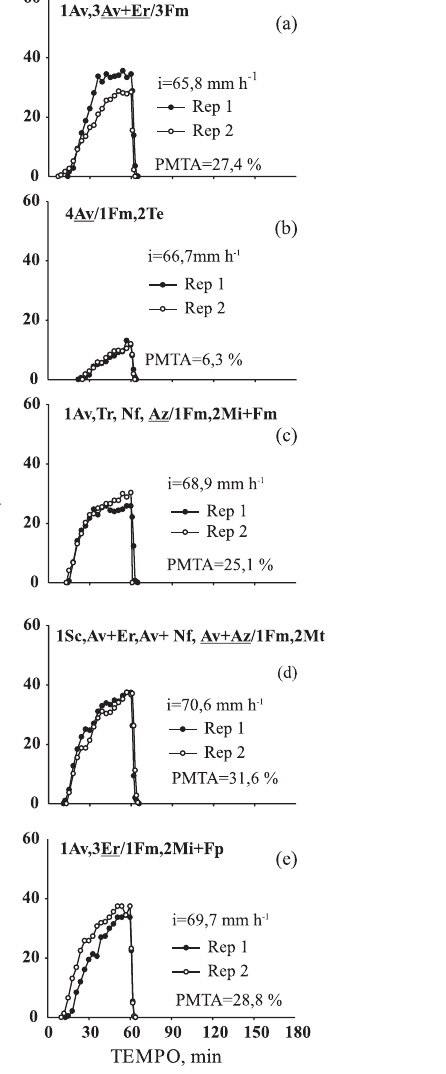
Figura 2. Taxas instantâneas de descarga da enxurrada (TDE) no terceiro (T3: solo não imobilizado, raízes mortas, crosta recente, 18 % coberto - figuras (a) a (e), à esquerda) e no quarto (T4: solo recém- escarificado, raízes mortas, 100 % coberto - figuras (f) a (j), à direita) teste de erosão com chuva simulada, nas sequências culturais estudadas (Av: aveia-preta, Er: ervilhaca, Fm: feijão-miúdo, Te: teosinto, Tr: trevo-calypso, Nf: nabo forrageiro, Az: azevém, Mi: milho, Sc: sem cultivo, Mt: milheto e Fp: feijão-de- porco). Valores individuais para cada repetição dos tratamentos (Rep 1 e Rep